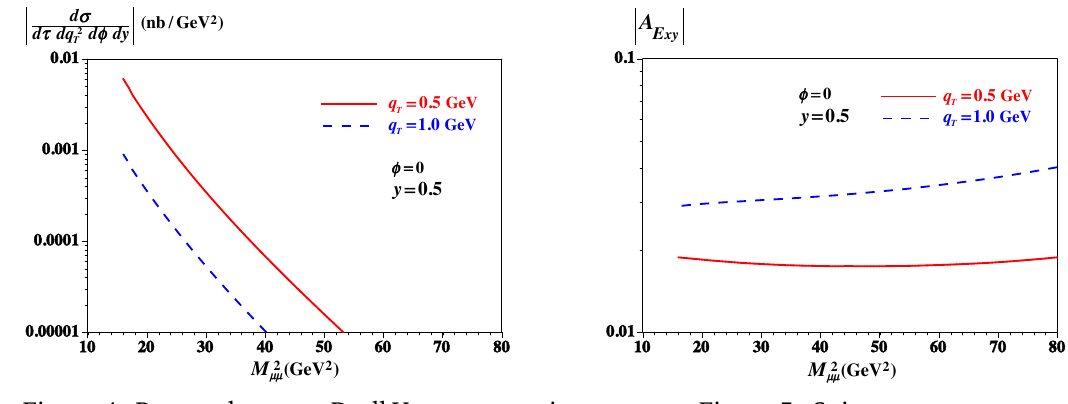
Figure 4: Proton-deuteron Drell-Yan cross section for the linear-polarization asymmetry E